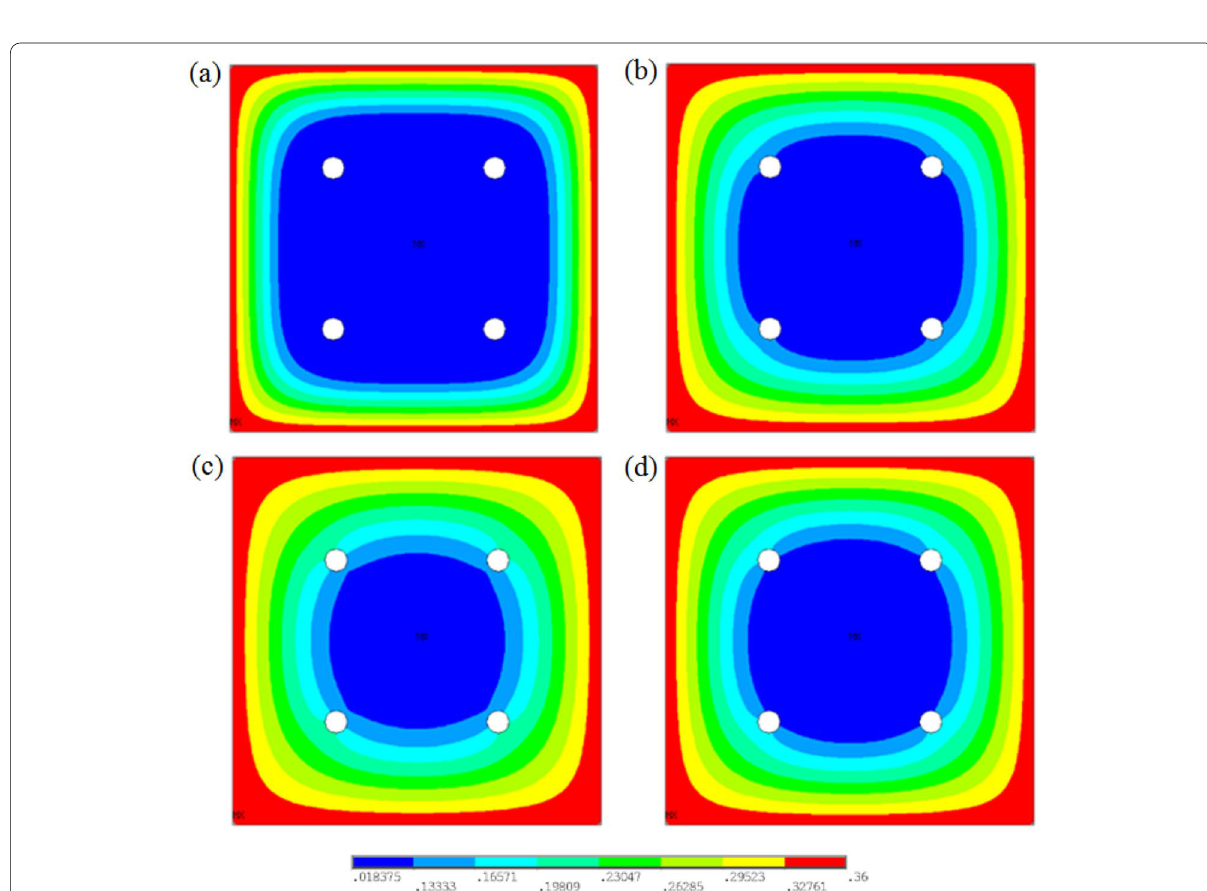
Fig. 10 Contours of carbon dioxide concentration in the normal concrete component: a for 7 days, b for 14 days, c for 21 days, and d for 28